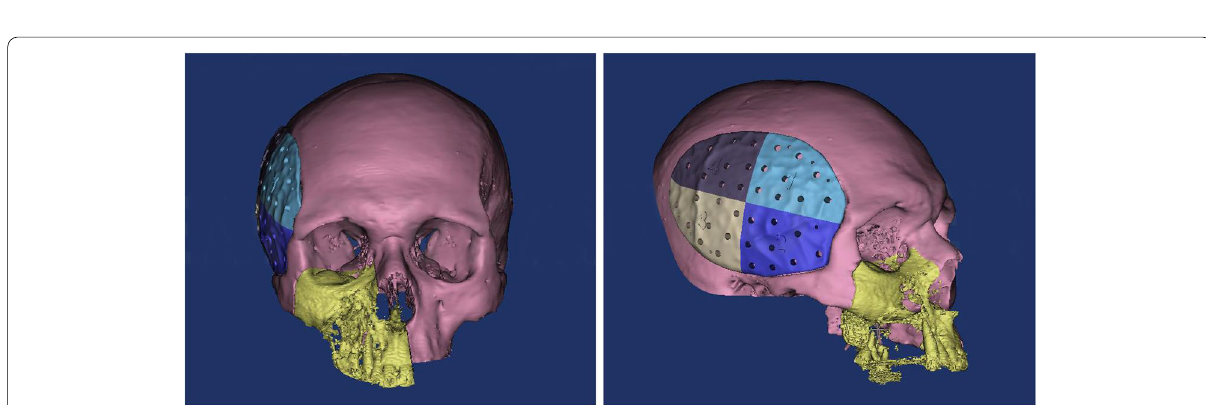
Fig. 3 The virtual implant formed of four interlocking